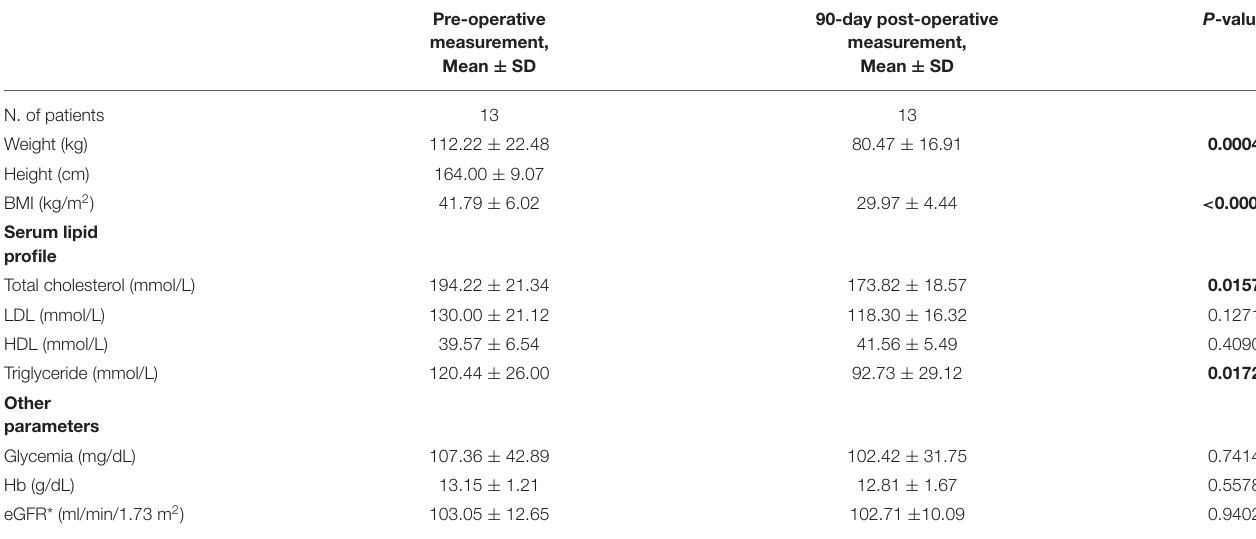
TABLE 3 | Outcomes after 90 days from BS.